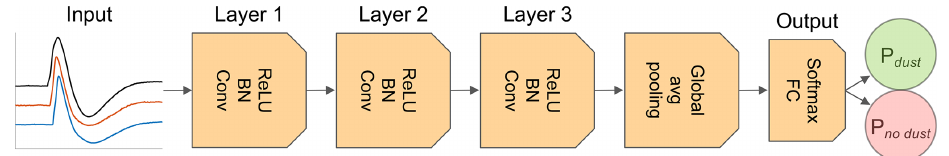
Figure 7. The three-layer fully convolutional network used for the dust impact classification task. The input to the network is the (3 × 4096) waveform. The feature extraction process is defined by three convolutional layers, consisting of 128, 256 and 128 independent filters with kernel lengths of 8, 5 and 3 weights, respectively. Batch normalization (BN) is used at each convolutional layer to regularize the inputs and the rectified linear unit (ReLU) function was used as the activation function. Finally, the output of the convolutional layers (with dimension 128 × 4096) is averaged in the global pooling layer to a feature vector with dimension (128 × 1). The class score is then determined in a fully connected (FC) network layer and the output label probabilities ( P dust , P nodust ) are calculated using the softmax function. The figure is adopted from Wickstrøm et al. (2021).